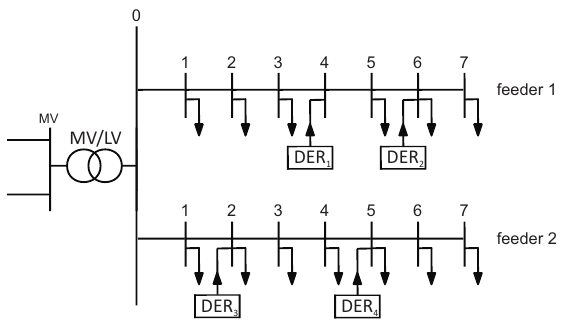
Figure 5. Case study distribution system. Table 1. Electrical parameters and loads for the branches of both the feeders. p.u.: per